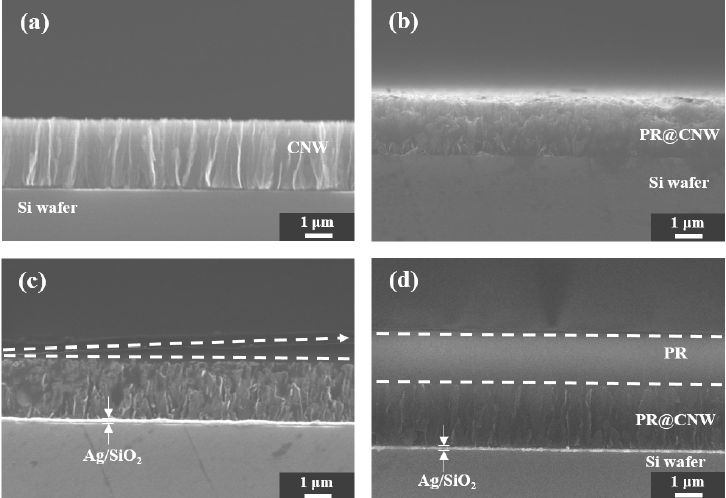
Figure 3. FESEM cross-sectional image of the ( a ) carbon nanowall (CNW), ( b ) photoresist (PR)@CNW, and ( c ) PR@CNW between the desired and non-removed areas, and the ( d ) PR-coated CNW. To determine the reason for the strong bond between the PR and the CNW, the contact angle between the DI water and the CNW was confirmed, as shown in Figure 4a. Water molecules are polar and do not mix well with non-polar molecules like oil. The contact angle of the CNW was 81°, which means that it was hydrophobic and non-polar. On the contrary, the SMCNW in Figure 4b has a low contact angle with DI water due to activation of the functional group on the nanowall surface, and is hydrophilic and polar. The extreme change in the contact angle through surface modification of the nanowall can also be explained by the Laplace pressure, which results from the difference in surface energy between the nanowall and the buffer layer [27,28]. The PR that was used in this study was a non-polar molecule. As a result, the mixing of non-polar molecules caused strong adhesion, enabling the PR@CNW to remain even after the development process. Figure 4c explains why SMCNW has low adhesion to PR, unlike CNW. As with the polar molecular formation on the surface, which is the reason for carrying out the dehydration baking process, SMCNW was employed to reduce the adhesion between the CNW and the PR.